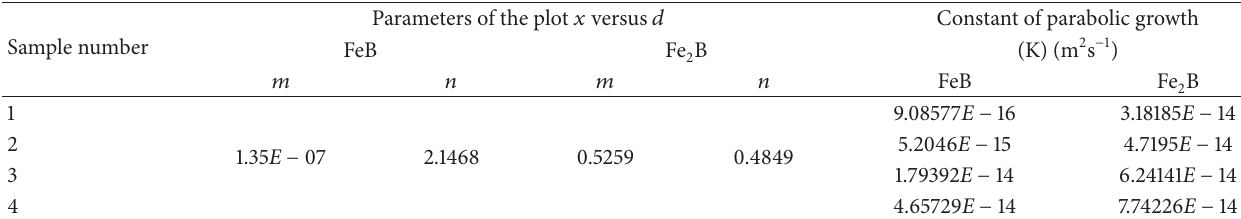
Table 3: Behavior of the constant of parabolic growth of the FeB and Fe inner diameter of the